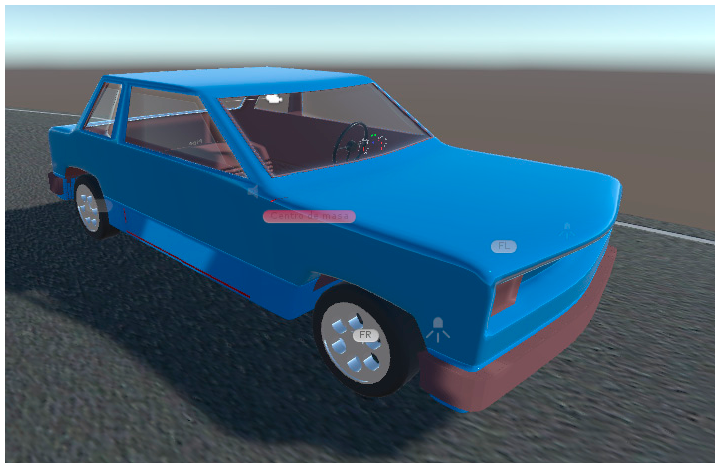
Figure 3. Virtual automobile with avatar.